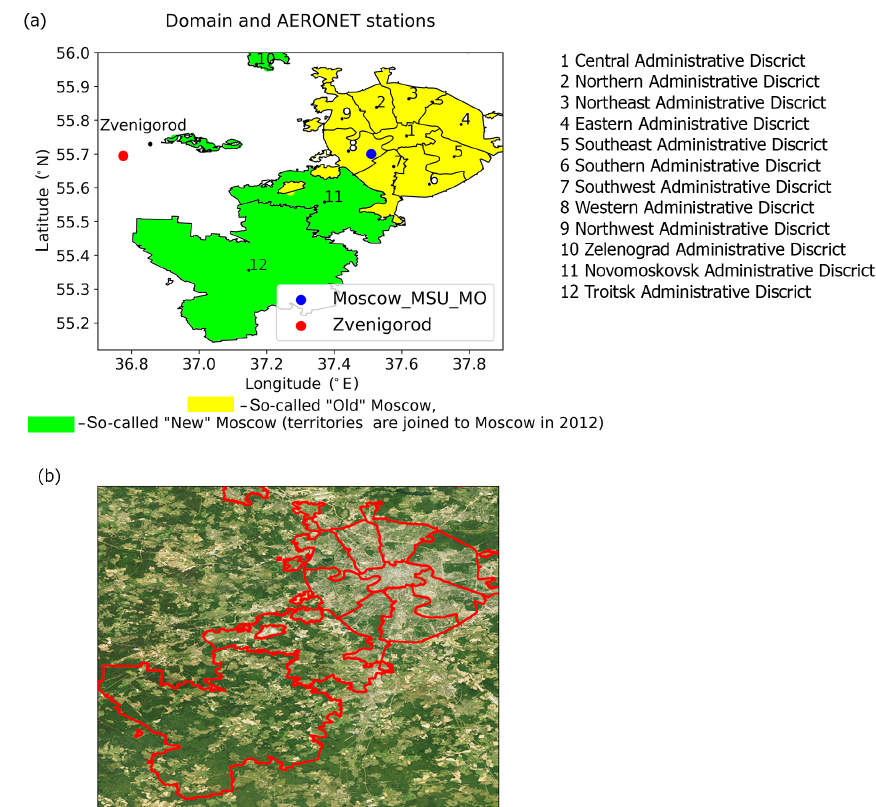
Figure 1. Study domain and locations of AERONET sites. (a) “Old” and “New” Moscow, administrative districts. (b) Satellite image (ArcGIS World Imagery: https://arcg.is/4zubf, last access: 20 December